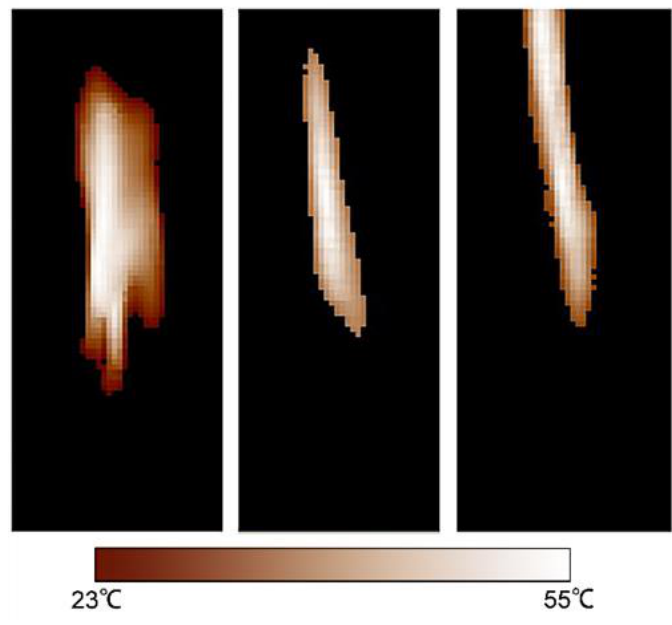
Figure 9. Pseudo-coloring of temperature infrared images.